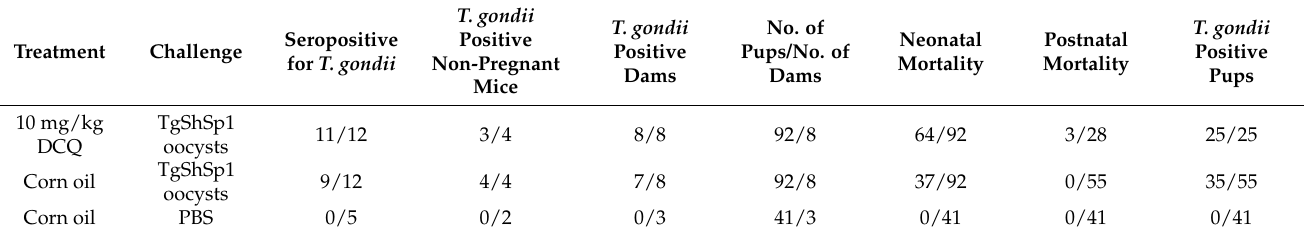
Table 2. Litter size, parasite burden, neonatal and postnatal mortality rates of T. gondii infected mice treated with